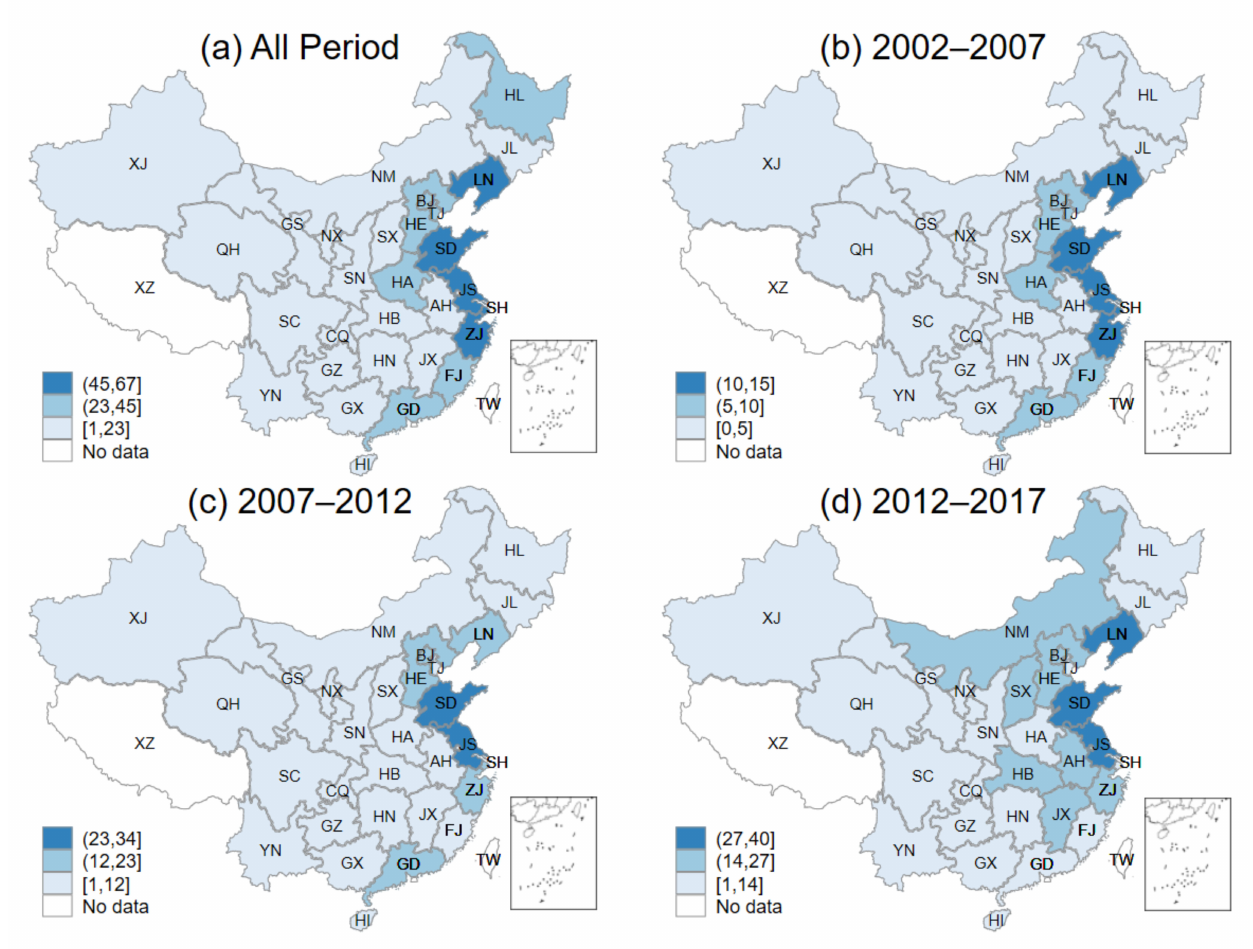
Figure 3. Provincial national economic growth effect: ( a ) all periods; ( b ) 2002–2007; ( c ) 2007–2012; ( d )